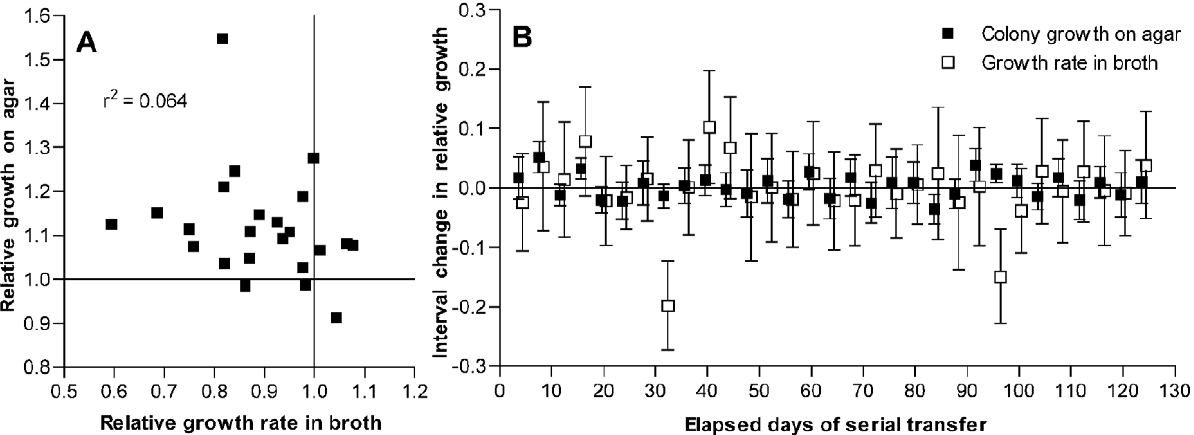
Figure 3. Changes in fitness of passaged isolates for growth on agar plates as compared to broth. (A) Growth on THY agar plates as compared to growth in THY broth for isolates after 126 days of serial transfer. Values are given relative to the average of day 1 control isolates as described for Figure 1. Correlation between these measurements is not significant ( P =0.24). (B) Interval changes in relative growth on THY agar plates or in THY broth culture for isolates from a single S. pneumoniae line taken every 4 days during serial transfer. Growth is measured as log 2 (CFU/ colony) or as maximum broth growth rate, both relative to similar measurements for the preceding sample in the series. Error bars represent 95% confidence intervals for the differences between consecutive samples from individual t-tests based on at least 10 measurements of broth growth and 12 measurements of CFU/colony for each isolate. ANOVA with Bonferroni correction demonstrated significant changes in broth fitness at days 32 and 96 ( P , 0.001 for each post test) and in agar fitness at days 8 ( P , 0.001) and 92 ( P , 0.05). Additional CFU/colony measurements were performed for isolates at days 16 and 96 that showed possible changes on initial testing. By individual t-tests, these changes at day 16 ( P =0.0005, n=24) and day 96 ( P =0.0034, n=51) were also